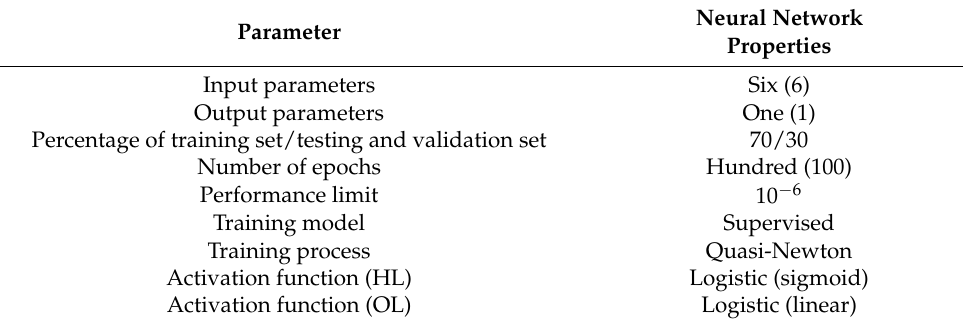
Table 2. Neural network properties.